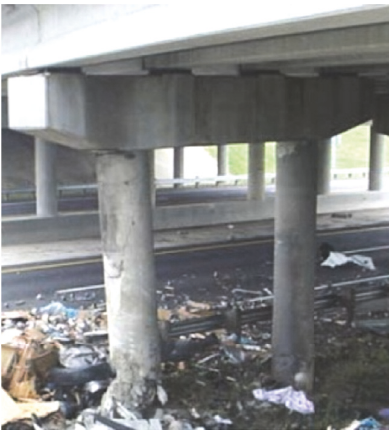
Figure 11: Failure mode of the pier of [2].